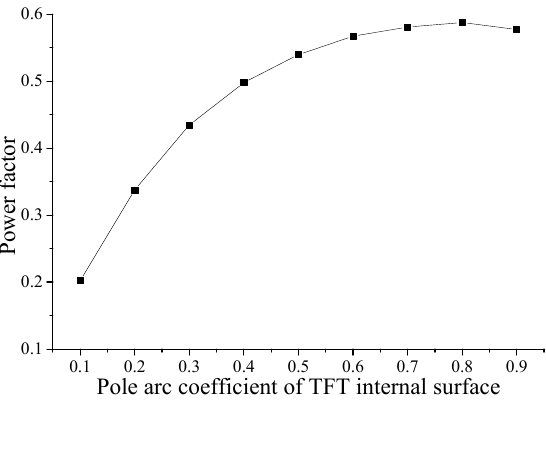
Figure 18. Variation of power factor versus pole arc coefficient of the TFT internal